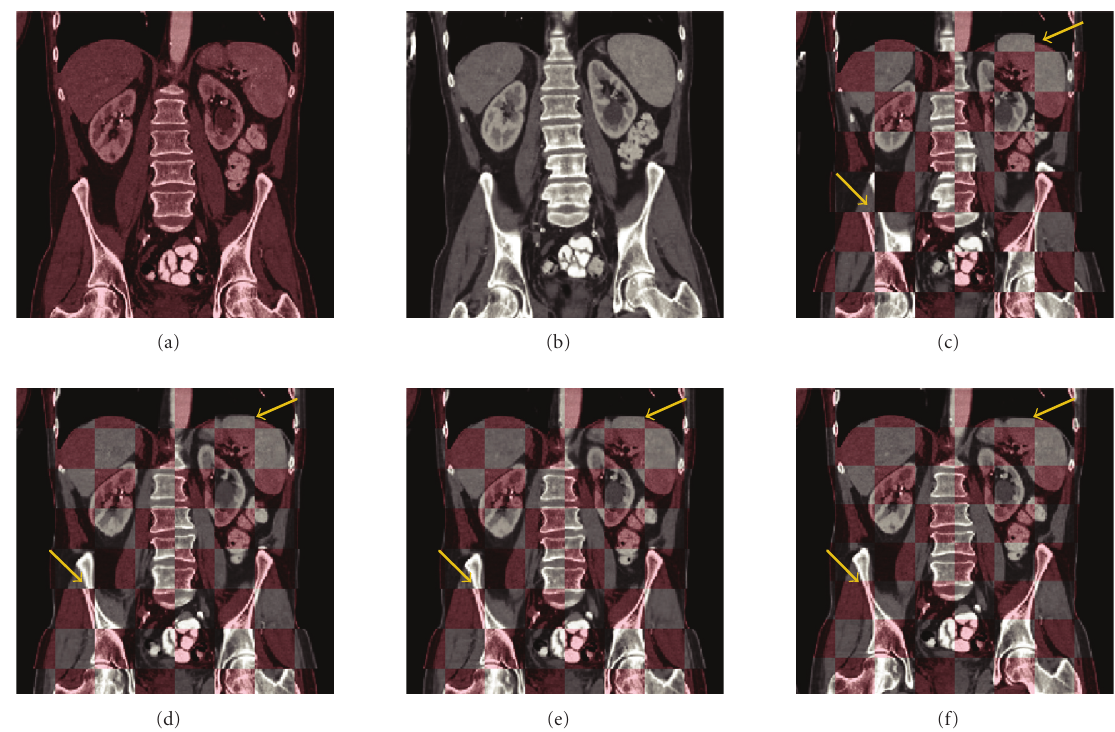
Figure 10: Results of image registration performed using the high-speed, reconfigurable implementation: (a) and (b) two distinct poses; (c) fusion of (a) and (b) using a checkerboard pattern. The misalignment between images is evident at the edges of the squares within the checkerboard pattern; (d)–(f) fusion images after registration using the identified design configurations. These configurations o ff er progressively reduced image registration error (3.82mm, 1.57 mm, and 0.45 mm, resp.) and result in correspondingly improved image alignment. The arrows indicate representative regions with misalignment that are better aligned after